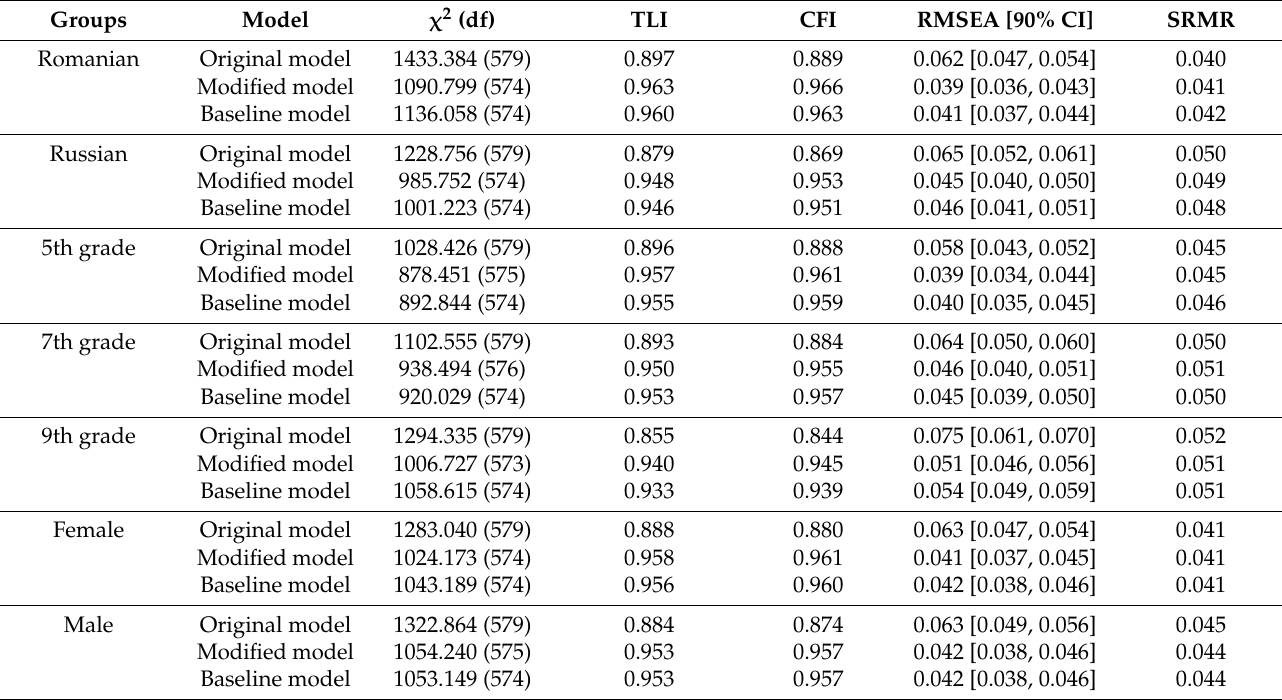
Table 7. Goodness of fit statistics: Baseline